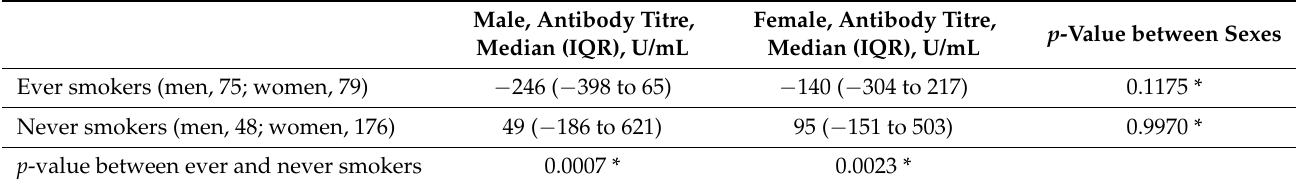
Table 3. Age-adjusted median antibody titres in ever smokers vs. never smokers. Male, Antibody Titre,